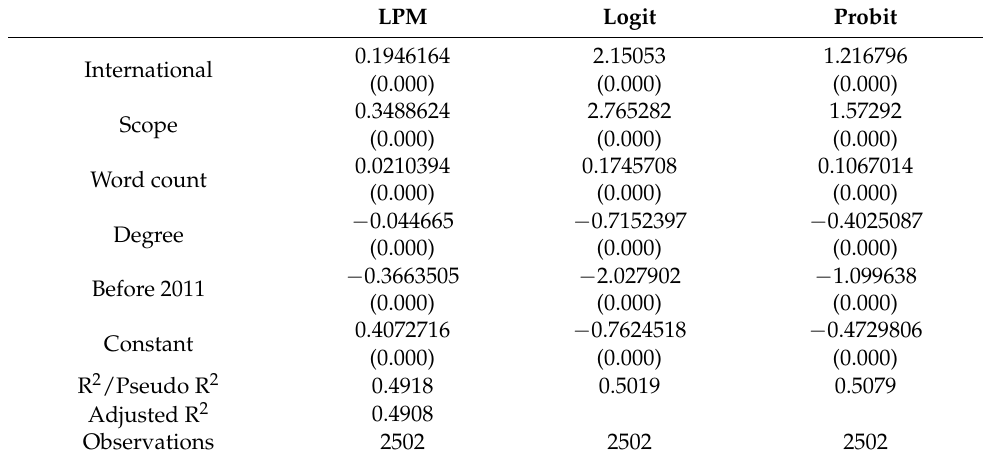
Table 4. Regression